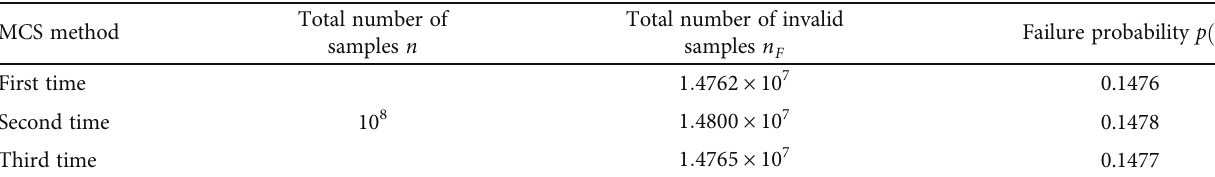
Table 15: Calculation results obtained from the MCS.